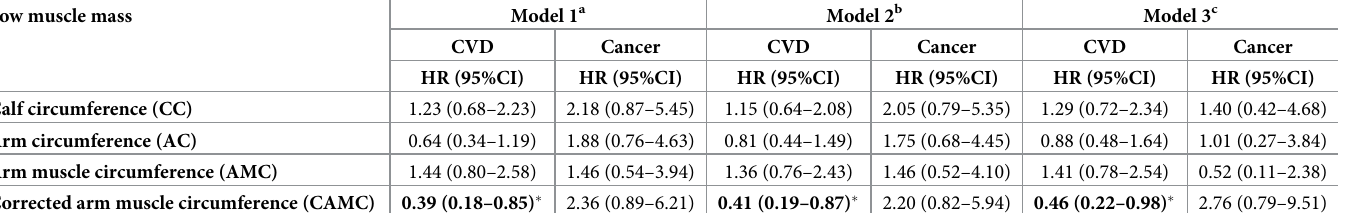
Table 5. Fully adjusted to Cox’s proportional risk to assess associations of low muscle according to anthropometric measures with CVD mortality (n = 49) and Can- cer (n = 22).